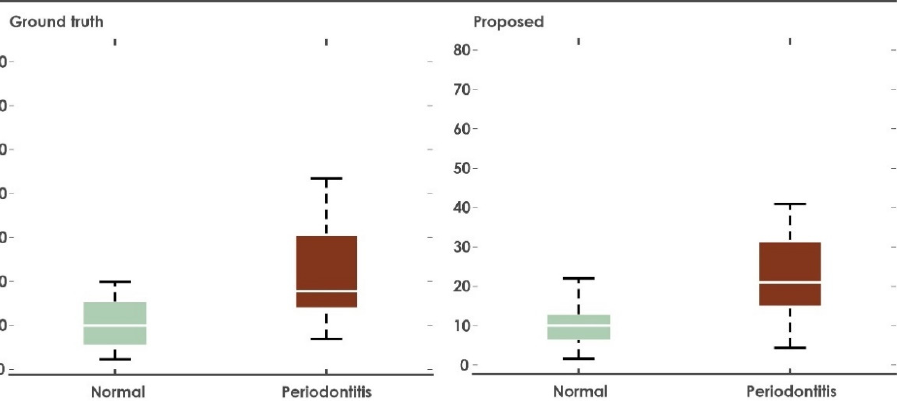
Figure 6. Box plot of ACA values obtained by computer tool and ground truth in radiographs of normal and periodontitis groups. normal and periodontitis Table 1. Descriptive of Alveolar space area and the alveolar crest angle as estimated by the computer tool and the ground truth in patients with or without periodontitis.